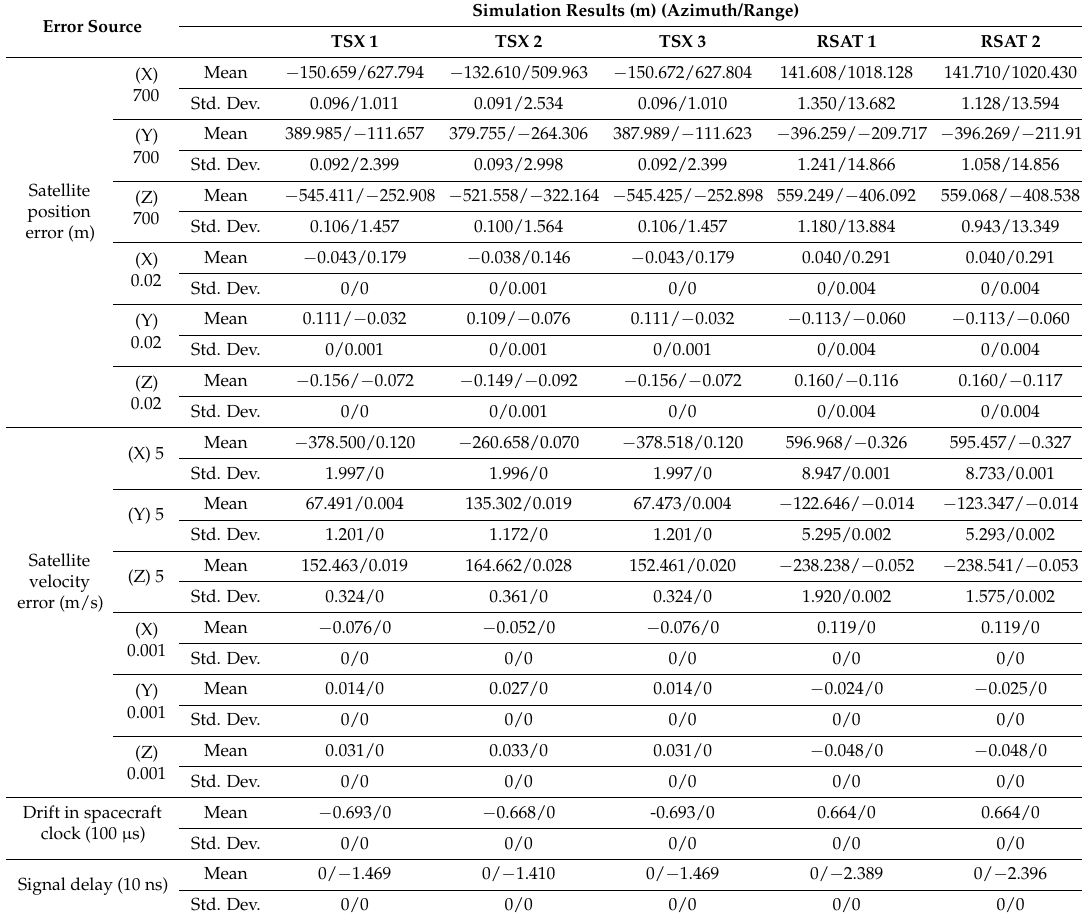
Table 4. Results of geolocation error simulation of orbit information and time-offset